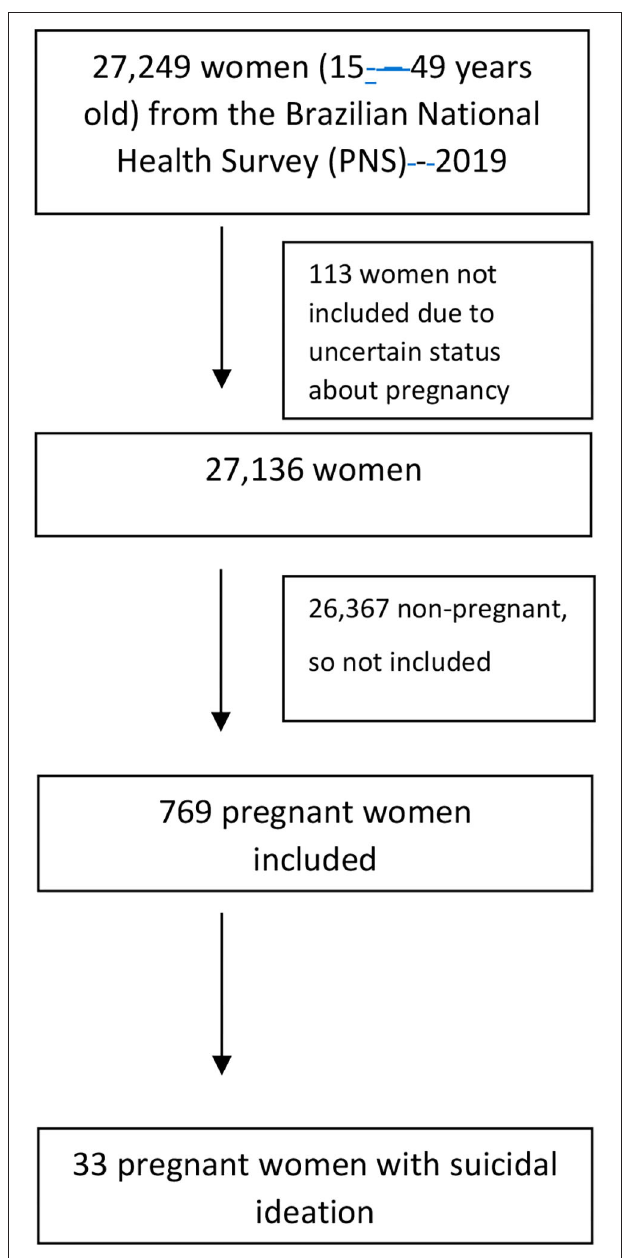
FIGURE 1 | Participant